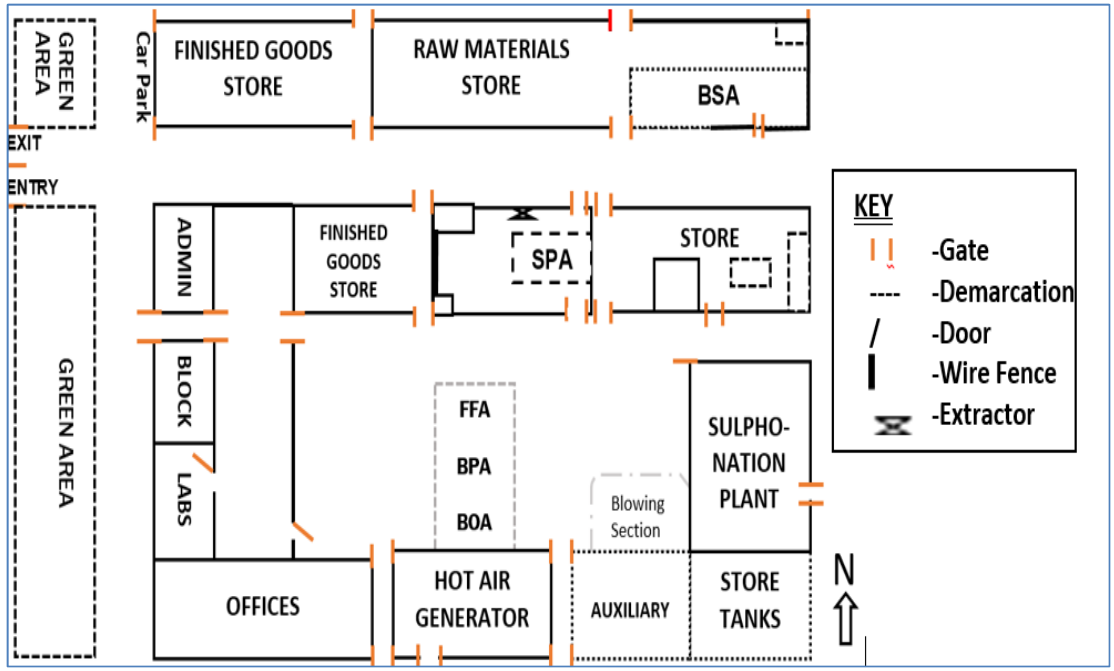
Table 2. Reported indoor air syndrome among employees of NHPL.